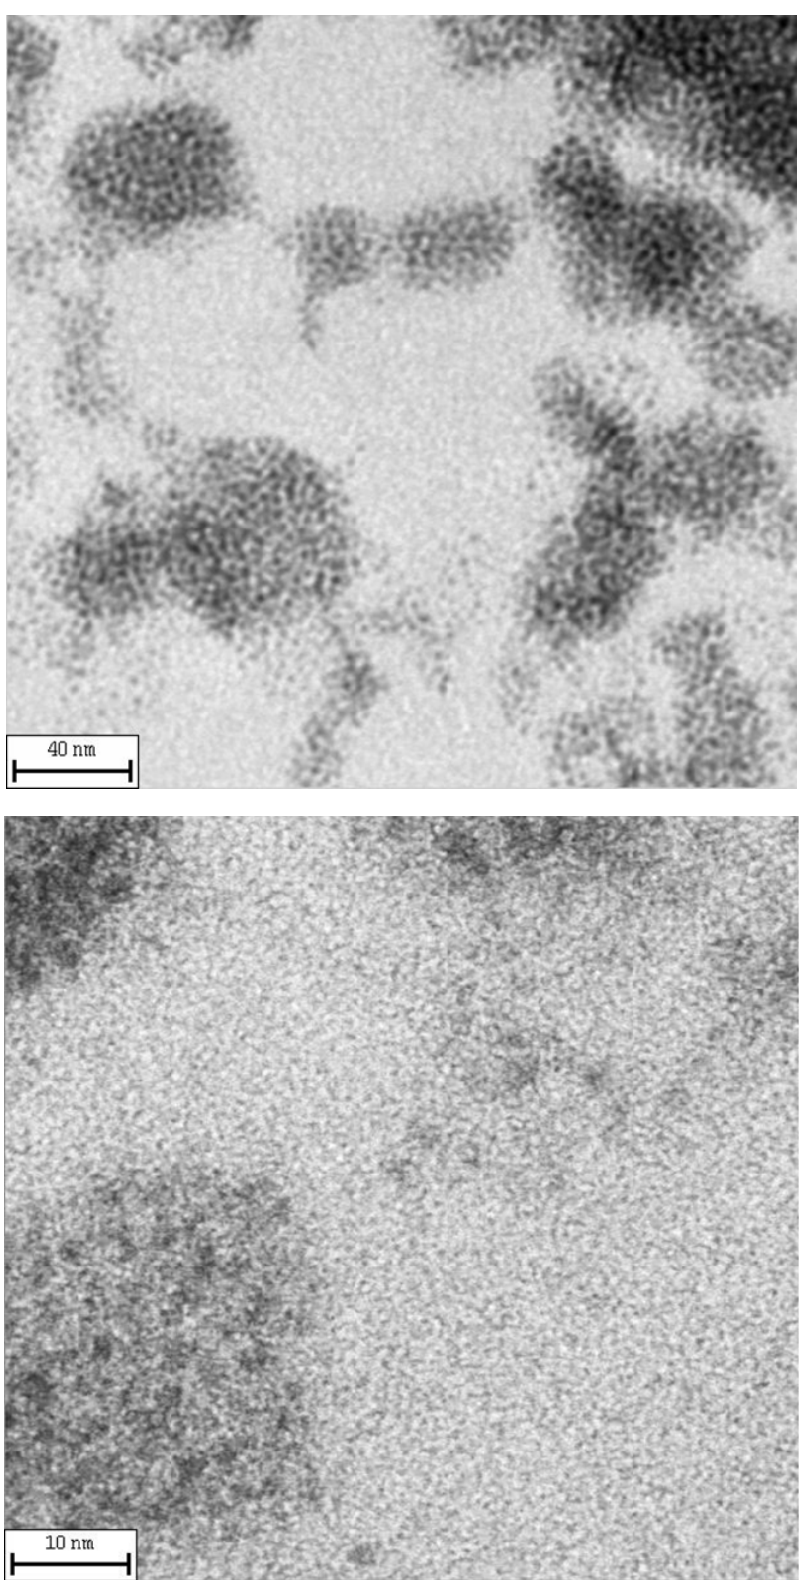
Figure 2. TEM-micrographs of Au clusters embedded into amorphous polystyrene (the AuSC H /polystyrene solution was isothermally annealed for 5 min at 170 °C). Owing to 12 25 the interdigitation and consequent co-crystallization of the thiol alkyl-chains coating the cluster surface, large cluster aggregates are present in this